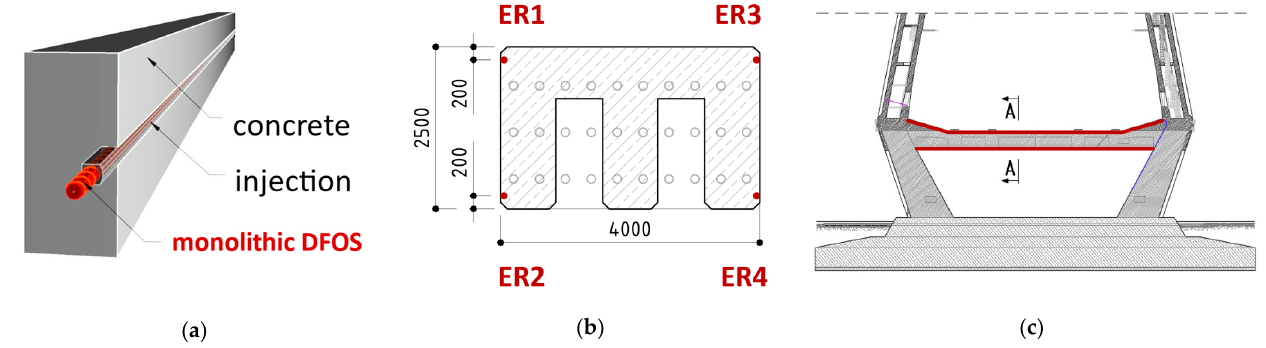
Figure 20. ( a ) Installation in near-to-surface grooves; ( b ) cross-section of the beam with locations of the sensors; ( c ) side view of the crossbeam with sensors marked over its length.